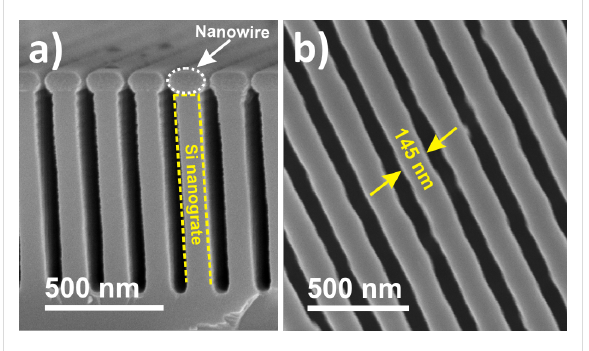
Figure 2: SEM micrographs of the post-annealed carbon-containing nickel nanowires on silicon nanograted structures. Cross section (a) and plan (b)